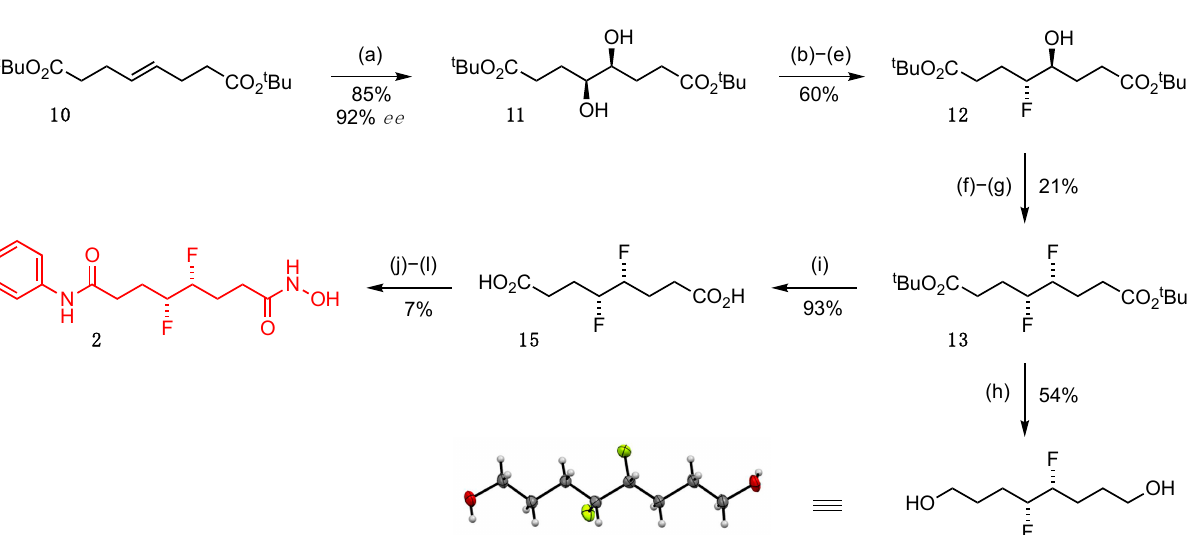
2 OsO 4 , (DHQ) 2 PHAL, K 3 Fe(CN) 6